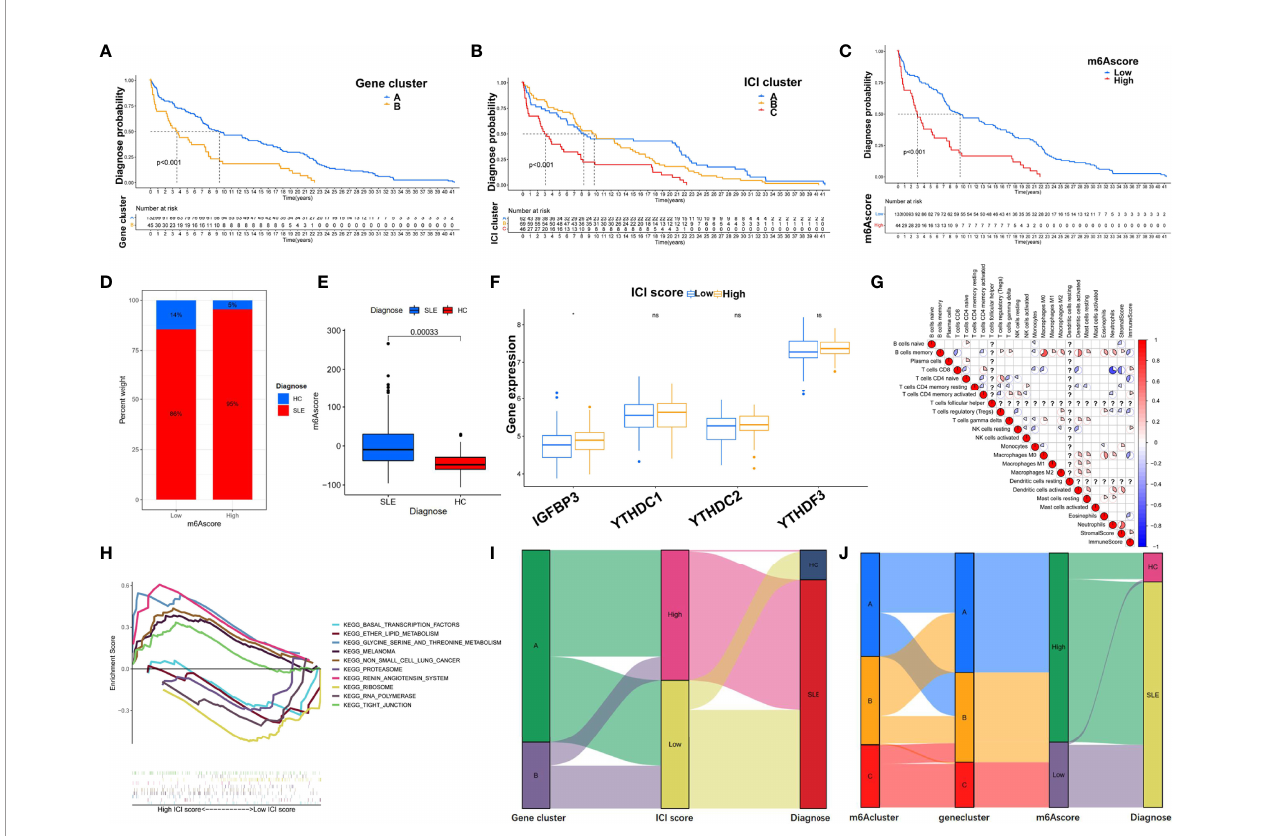
FIGURE 13 | Portfolio analysis of the m6A and ICI scores of the GSE49454 dataset. (A – C) Kaplan – Meier curves for diagnosing the probability of m6A score, ICI score, and gene cluster groups (log-rank test: p < 0.001). (D , E) The proportion of m6A scores and diagnosis differences in m6A scores between the SLE (red) and HC (blue) groups in GSE49454. (F) Gene expression differences of four m6A regulators between high- and low-ICI score groups. (G) A correlation coef fi cient heatmap was generated to visualize the immune cell interaction. (H) GSEA plots showing the processes of glycine serine and threonine metabolism, renin – angiotensin system, tight junction, non-small cell lung cancer, and melanoma signaling pathways in the high ICI score group and the pathways of basal transcription factors, lipid metabolism, proteasome, RNA polymerase, and ribosome in the low ICI score group. (I , J) Alluvial diagram showing the relationship of gene cluster, ICI core, and diagnosis and the relationship of m6A cluster, gene cluster, m6A core, and diagnosis. *p < 0.05; ns, not signi fi